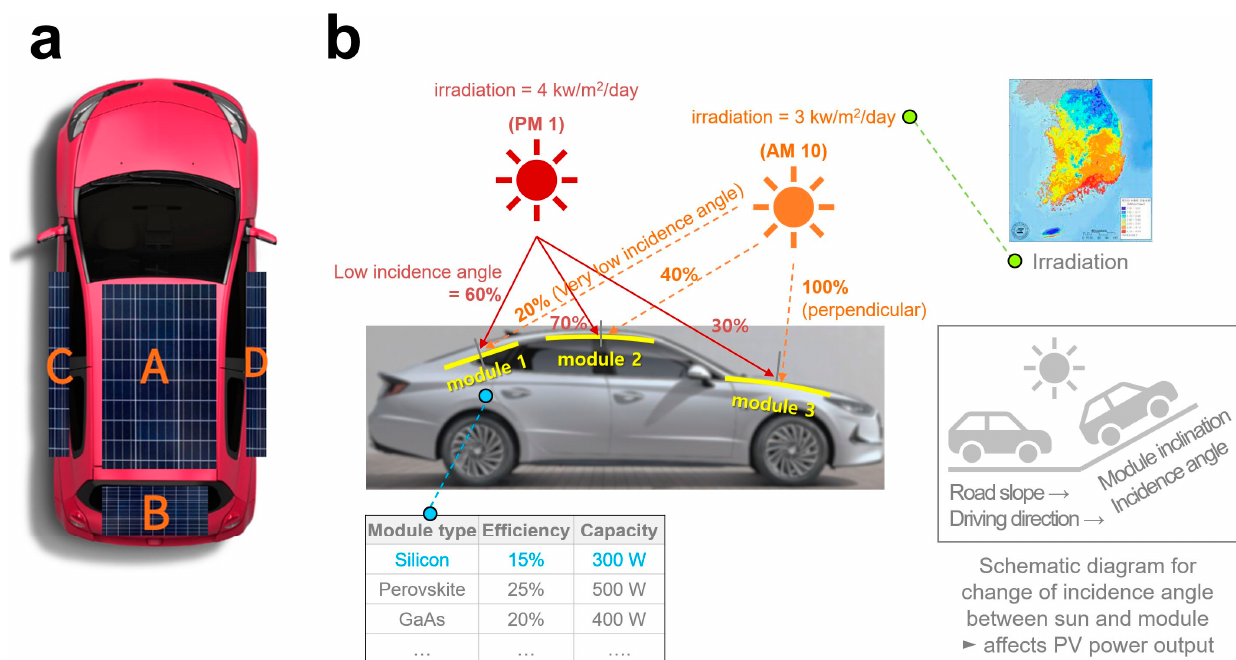
Figure 2. Modules attached to the vehicle ( a ) position of four modules (A: roof, B: rear window, C: left door, D: right door); ( b ) factors affecting the PV-powered EV potential.